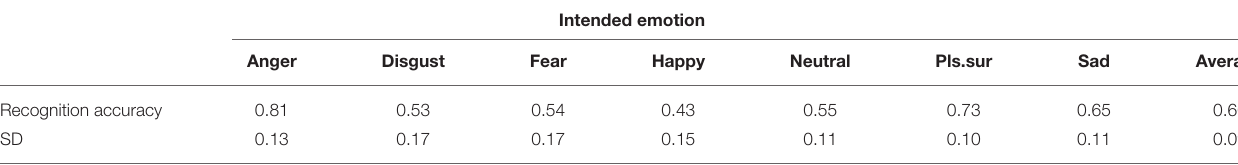
TABLE 2 | Mean arcsine-transformed H u scores and SD for each emotion and averaged across all emotions.